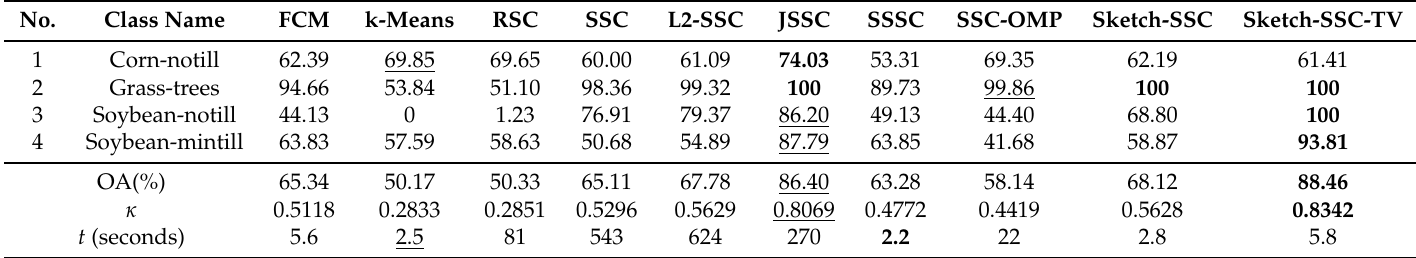
Table 1. Clustering results on the parts of Indian Pines .